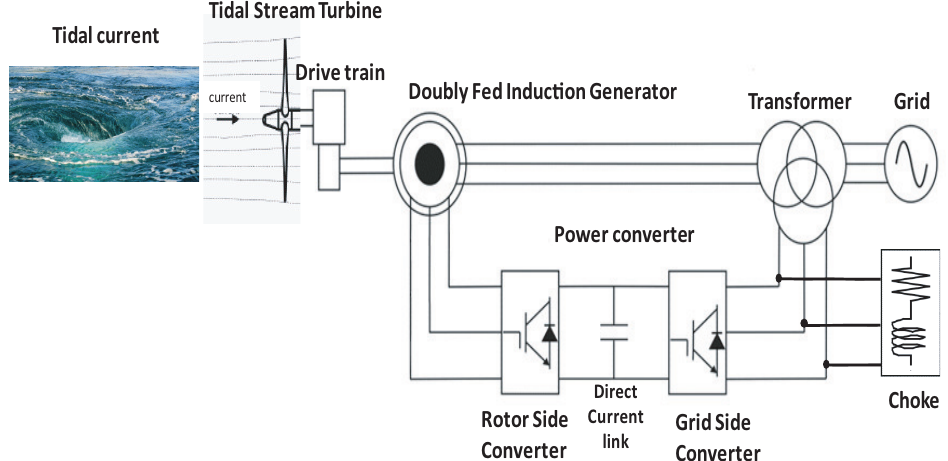
Figure 2. Scheme of the tidal stream generator system [30].